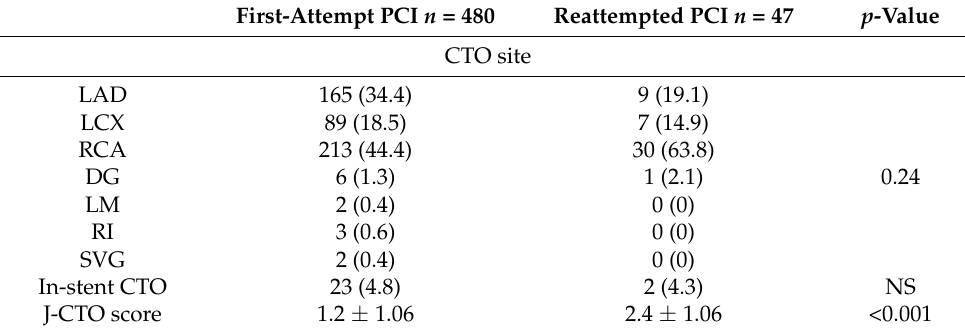
Table 2. Angiographic characteristics of first-attempt and reattempted CTO-PCIs.